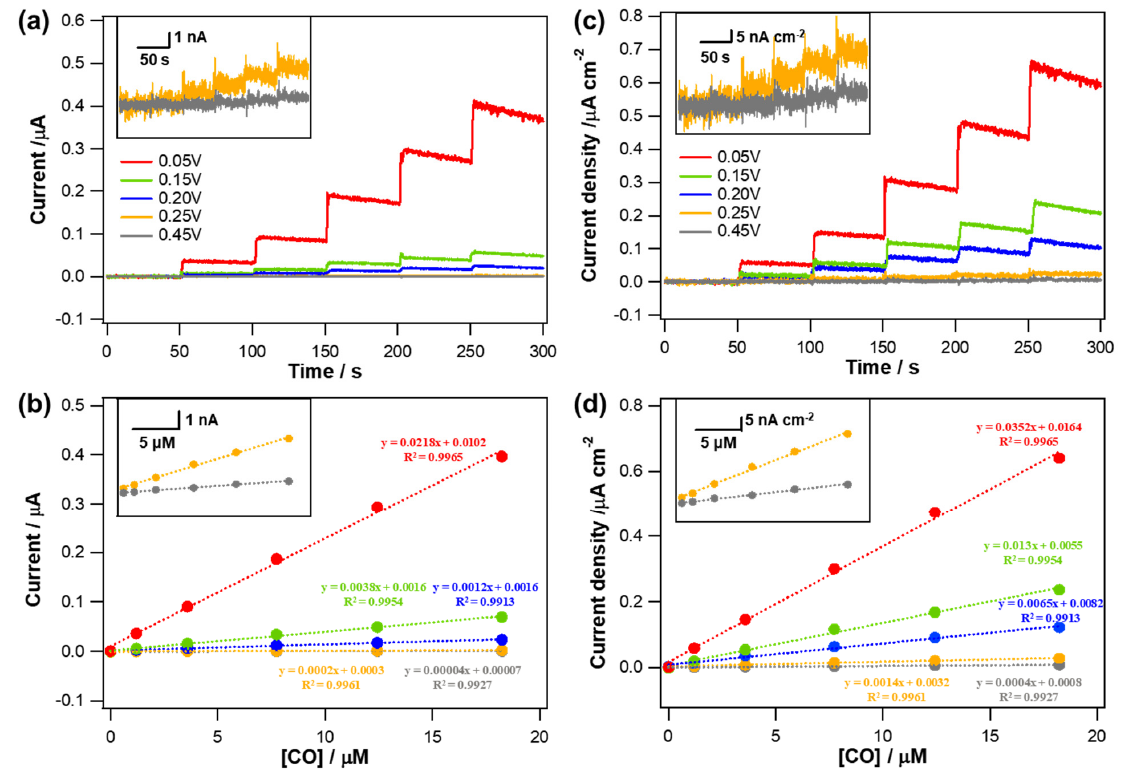
Figure 3. ( a ) Typical dynamic current response curves of the various Au electrodes electrodeposited at different deposition potentials (0.05 V to 0.45 V) to CO concentration changes (0~18.2 µM) in deaerated PBS solution (pH 7.4) measured at an applied potential of − 0.05 V (vs. Ag/AgCl); ( b ) the corresponding calibration curves. Insets show graphs for the Au electrodes electrodeposited at 0.25 and 0.45 V with a magnified y − axis scale. ( c , d ) The current data in ( a , b ) were normalized to the corresponding electrode ESAs.